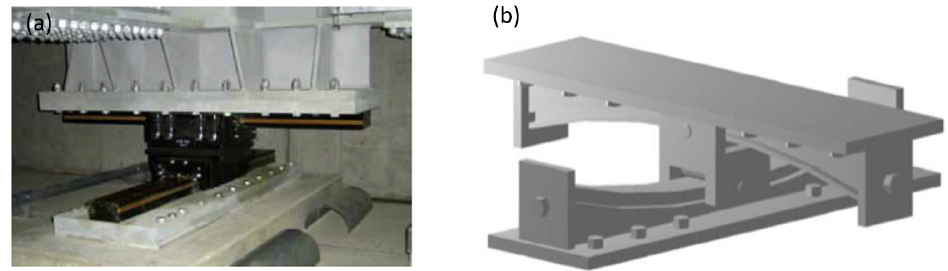
Figure 31. ( a ) Rolling ball mechanism in CLT. ( b ) Uplift retention mechanism in CSFS [145] .